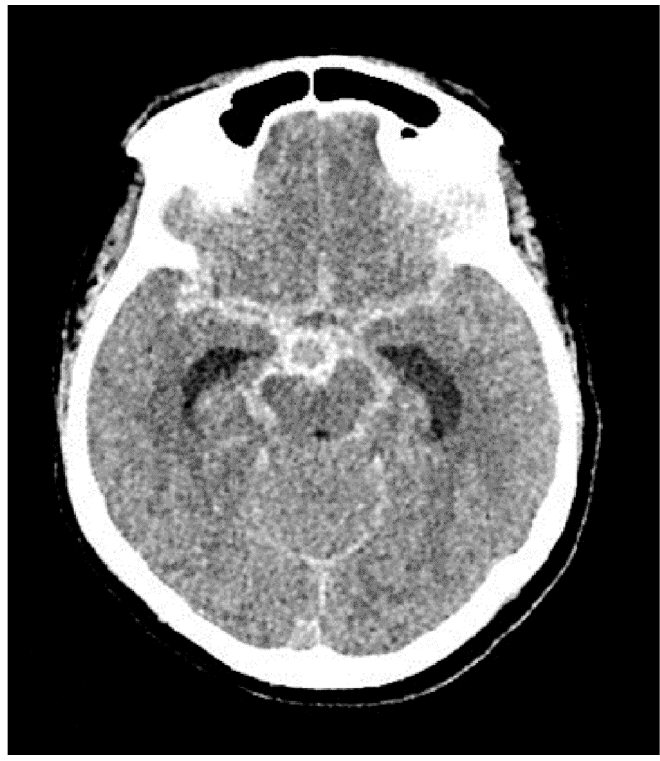
Figure 4. Case 2: Head Computed Tomography Showing Subarachnoid Hemorrhage Predominantly Around the Midbrain.